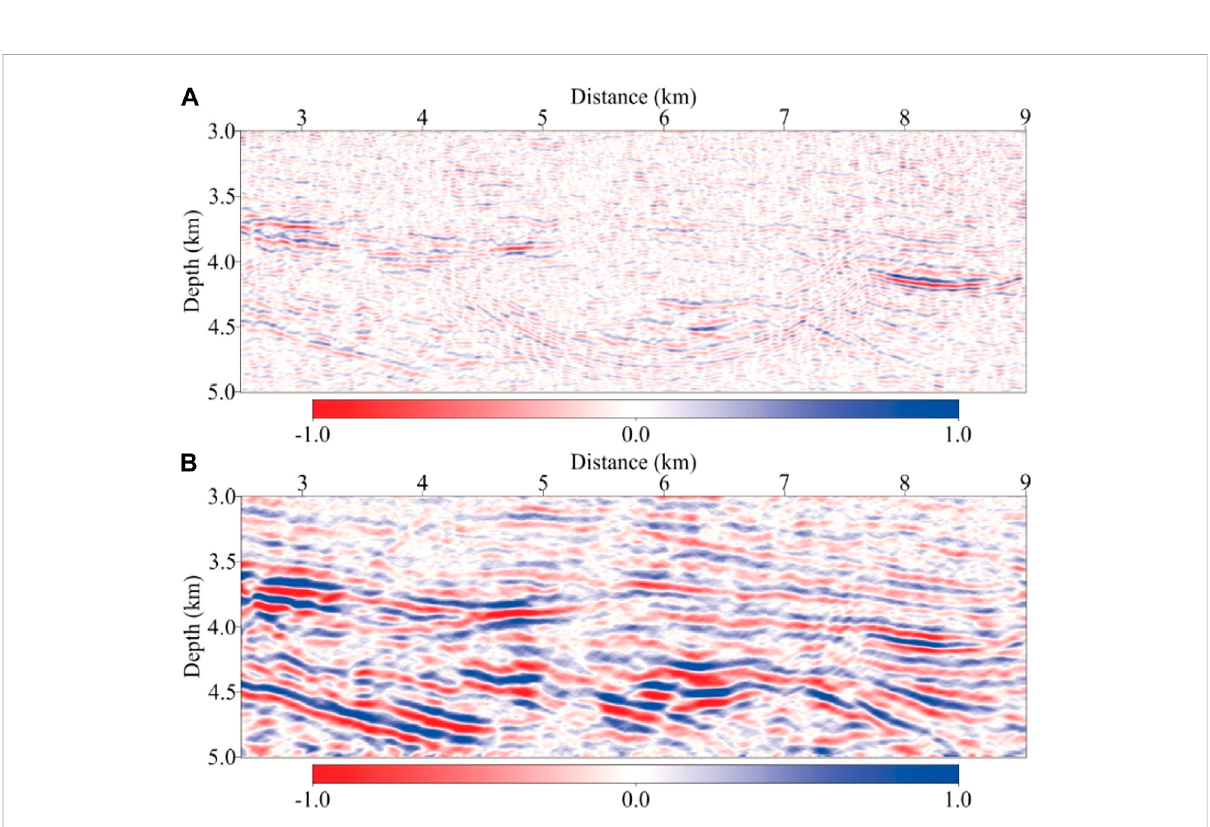
Zoomed views of solid box in Figure 17. (A) Viscoacoustic VTI RTM, and (B) viscoacoustic VTI LSRTM. And the color scales of all the images are the